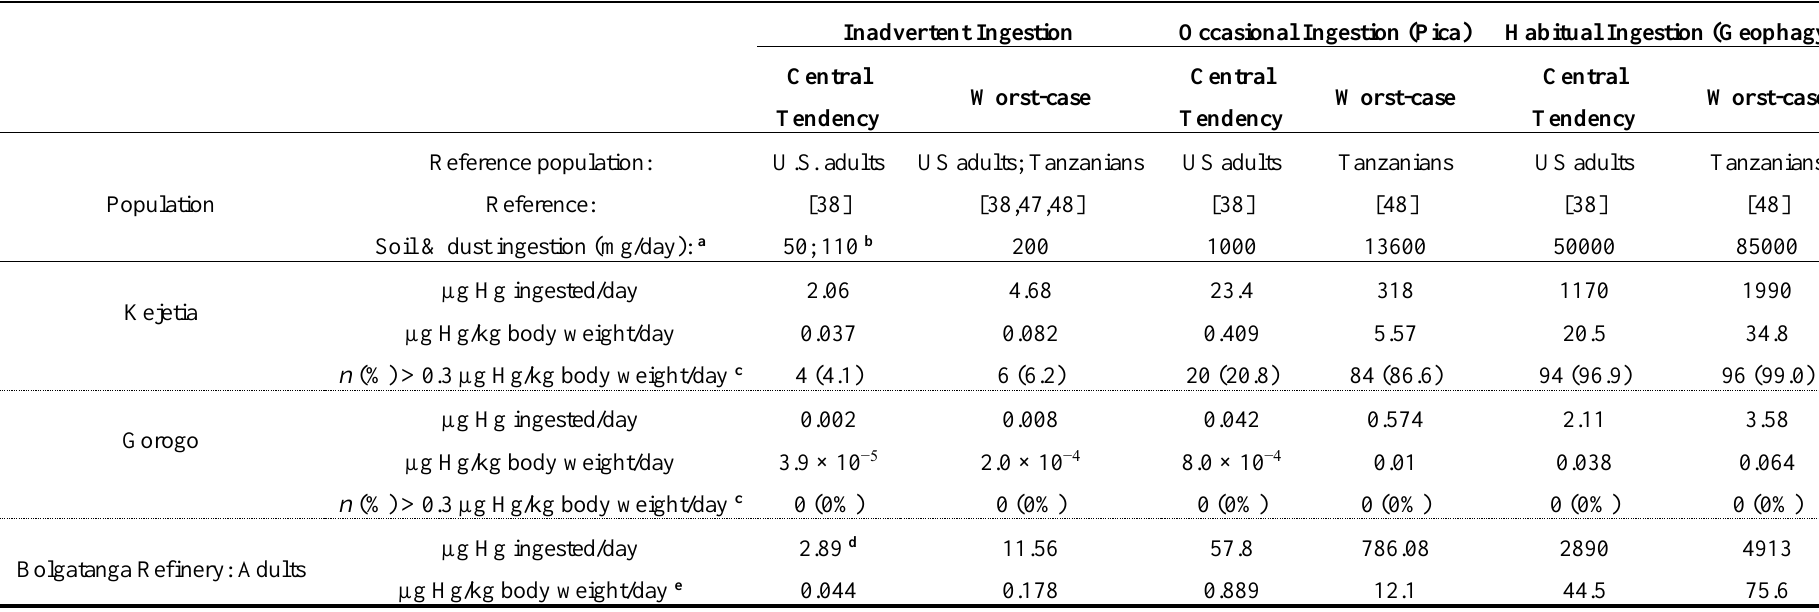
Inadvertent Ingestion Occasional Ingestion (Pica) Habitual Ingestion (Geophagy) Central Central Central Worst-case Worst-case Worst-case Tendency Tendency Tendency